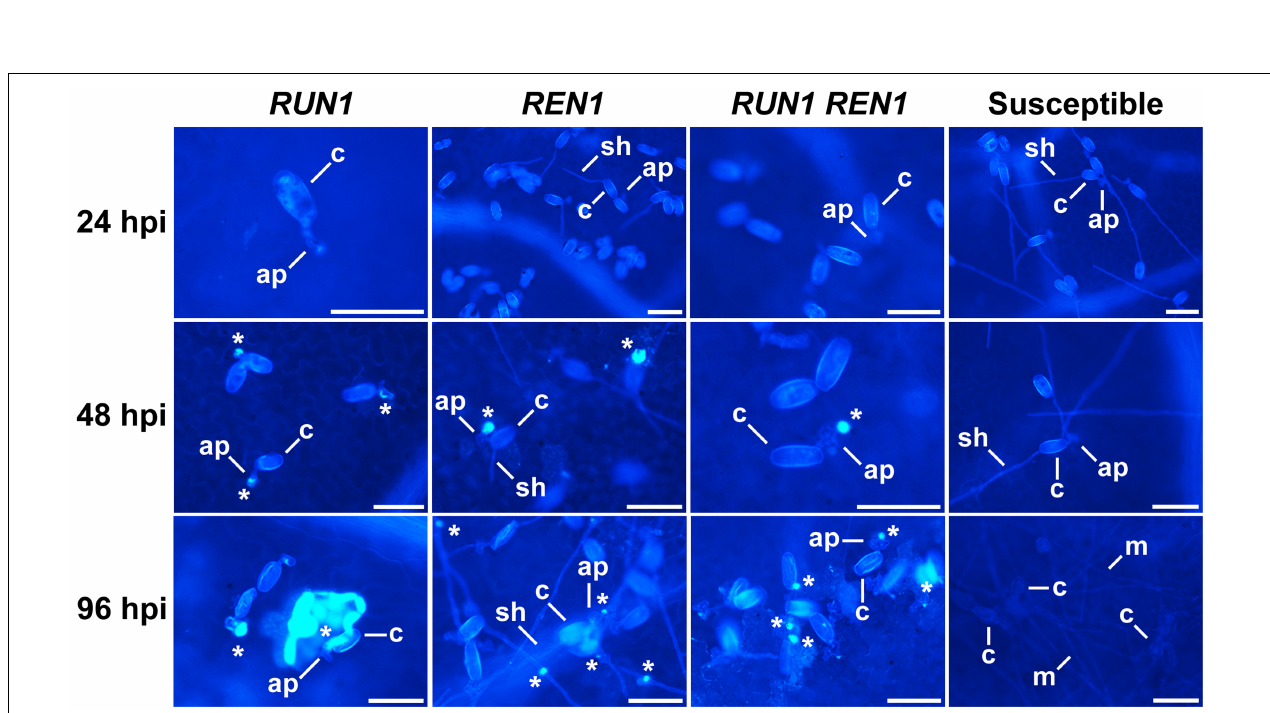
FIGURE 4 | Reactive oxygen species (ROS) generation at the E. necator infection site in segregating grapevine plants carrying RUN1 and/or REN1 loci. Samples were collected at 24, 48, and 96 hpi; c, conidium; ap, appressorium; sh, secondary hypha; m, mycelium; asterisks indicate brown diaminobenzidine-stained ROS in response to infection; scale bar, 50 µ m.